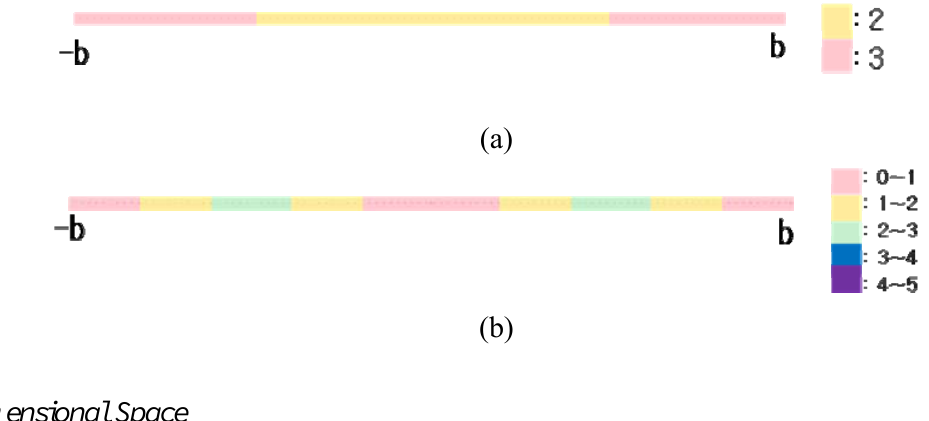
Figure 7. (a) Number of detected tags in best case (b) Scale of error in worst case.